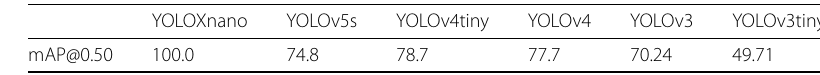
Table 2 Comparison of mAP@0.50 value of various Algorithm